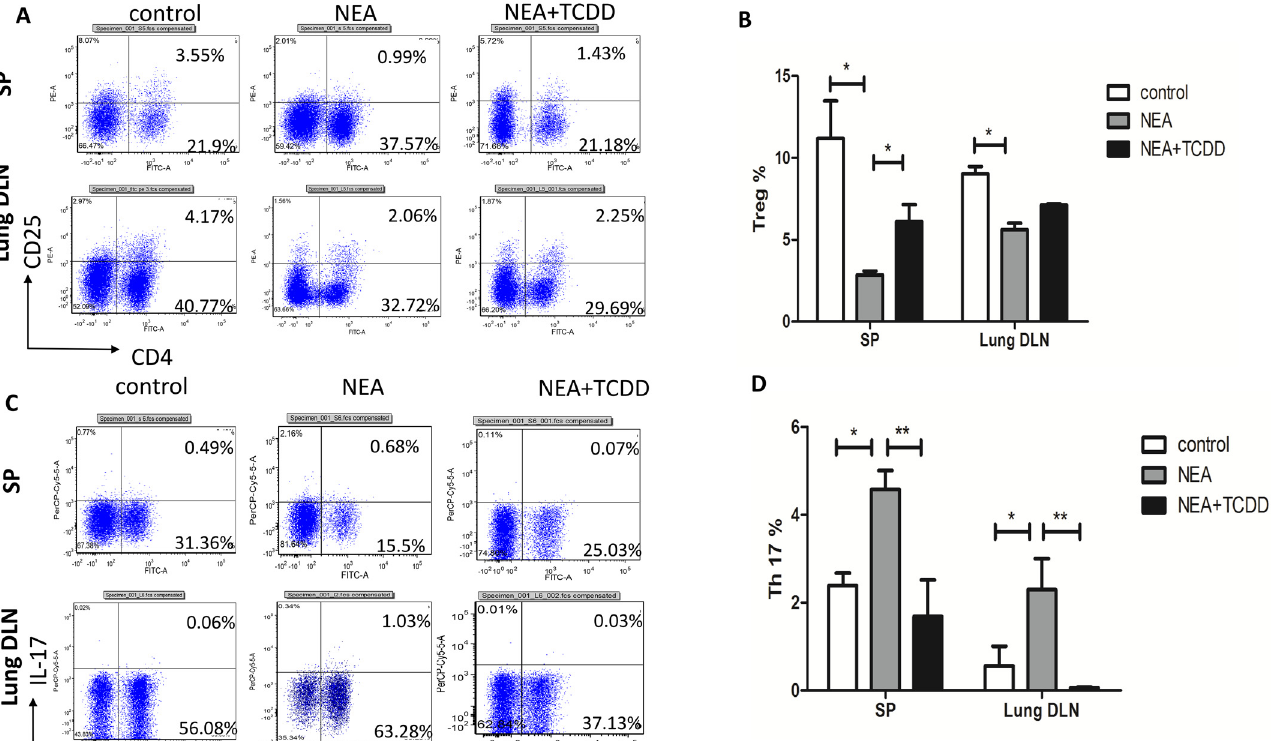
Fig 5. TCDD-induced AhR activation promoted Treg differentiation and inhibited Th17 differentiation. Cells from the spleens and lung-draining mediastinal lymph nodes were restimulated with leukocyte activation cocktail for 5 hours. (A-B) Five hours later, CD4+CD25+ cells were analyzed via cell surface staining. (C-D) IL-17-producing cells were analyzed via intracellular staining. The numbers within the quadrants indicate the percentage of positive cells in the total cells; the percentage of positive cells in the CD4+ cells (Treg% and Th17%) was subsequently calculated. N = 5 per group and * P < 0.05, ** P < 0.01.